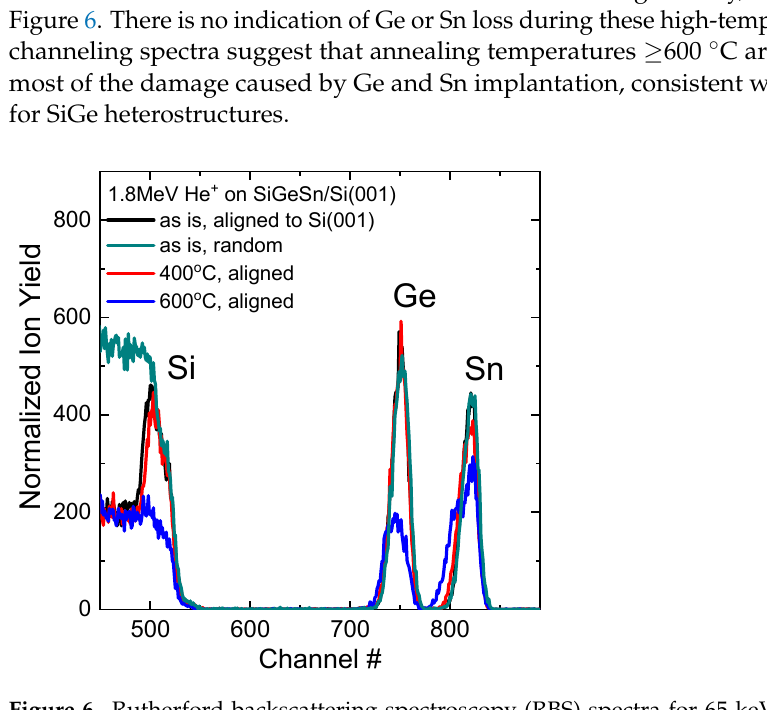
Figure 6. Rutherford backscattering spectroscopy (RBS) spectra for 65 keV Ge- and 100 keV Sn-implanted Si (001) samples annealed at high temperatures. Here, (001) is the Miller index of the original Si wafer. Spectra measured in the aligned geometry are compared to random geometry results.